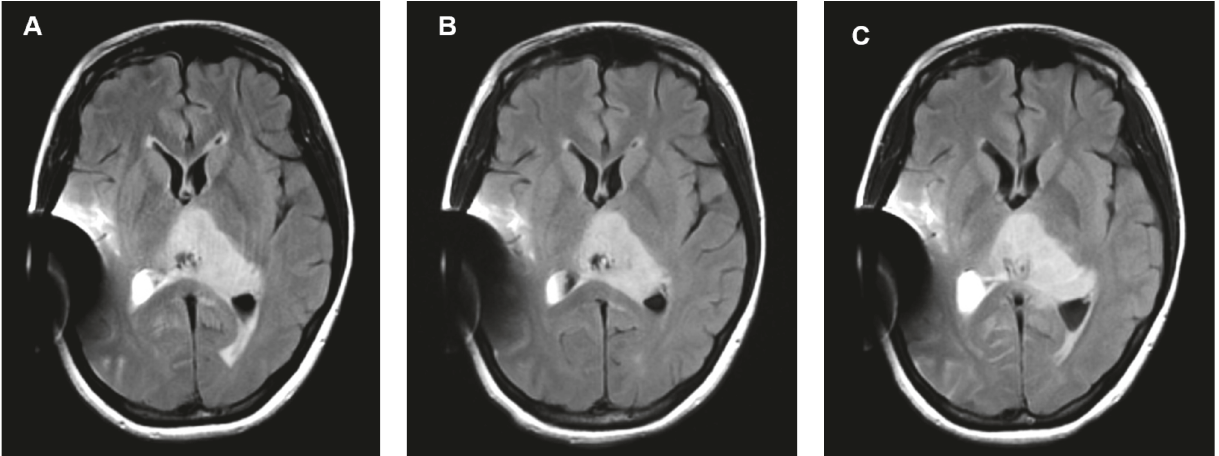
Figure 3: Follow-up MRIs conducted every 4 weeks revealed fluid attenuation inversion recovery and no change in tumor size and pattern of intensity ((A); shortly after surgery, (B); 4 weeks later, (C); 8 weeks